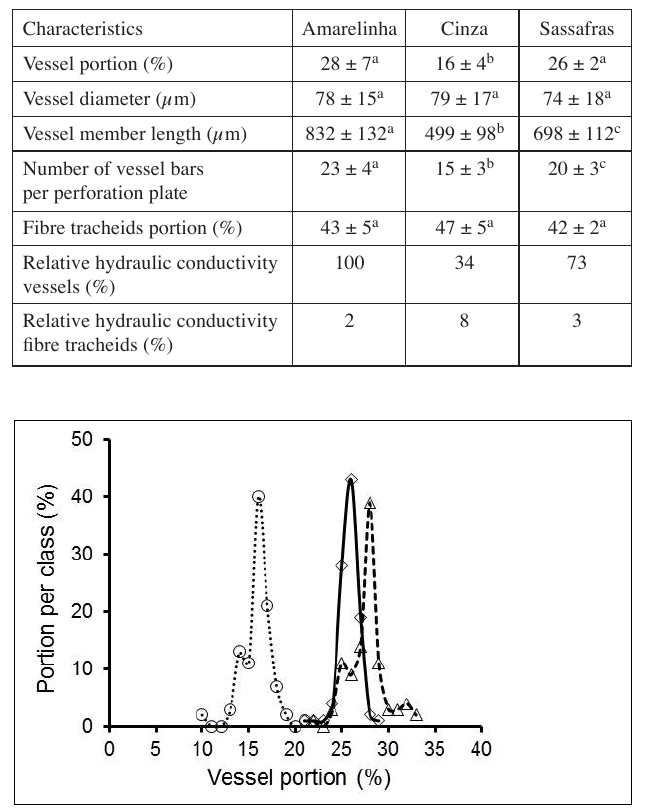
Tab. 2: Anatomical characteristics of the water conducting system and relative hydraulic conductivity in the xylem of the phenotypes “Amarelinha”, “Cinza”, and “Sassafras”. Mean value ± standard deviation. Values followed by different letters differ significantly at p<0.05 (Fisher’s F -test).